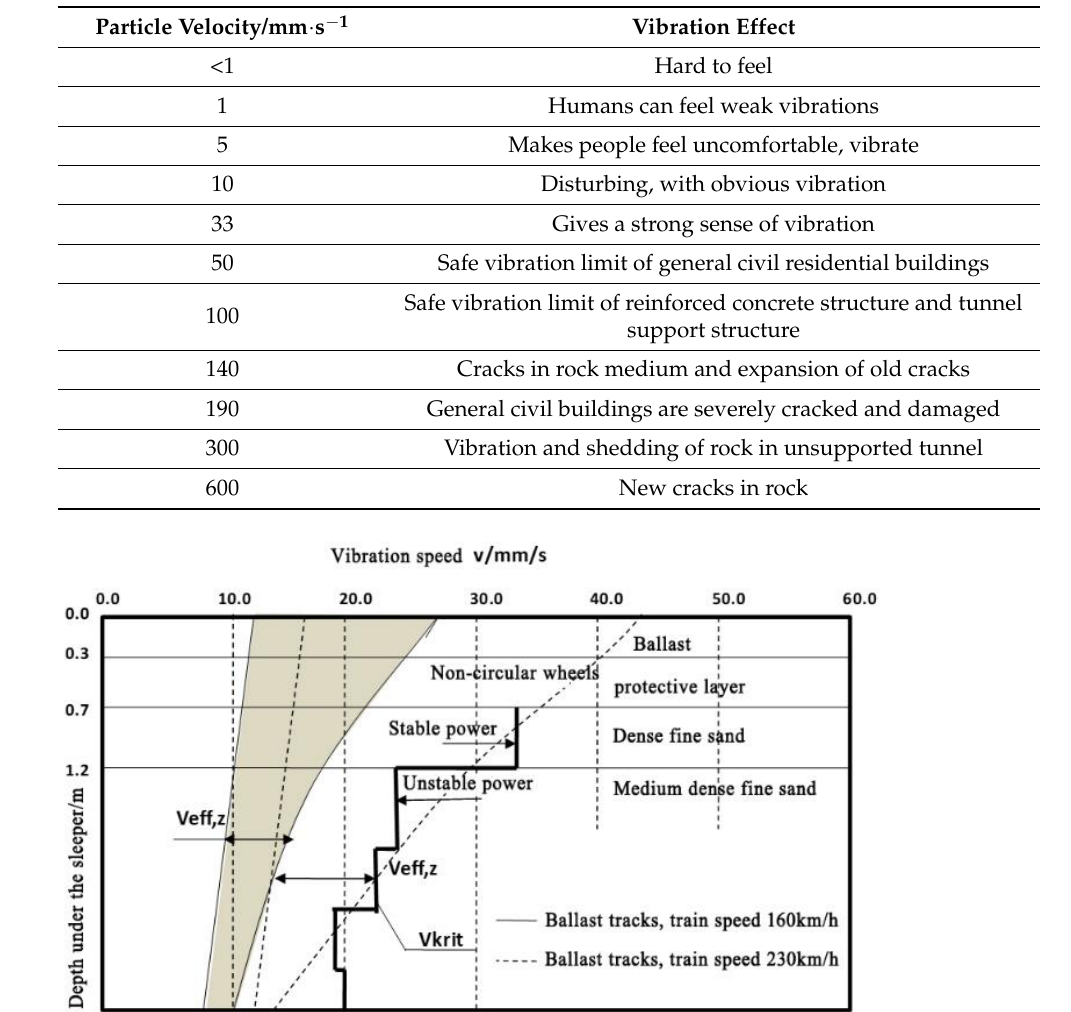
Table 3. Blasting vibration effect.